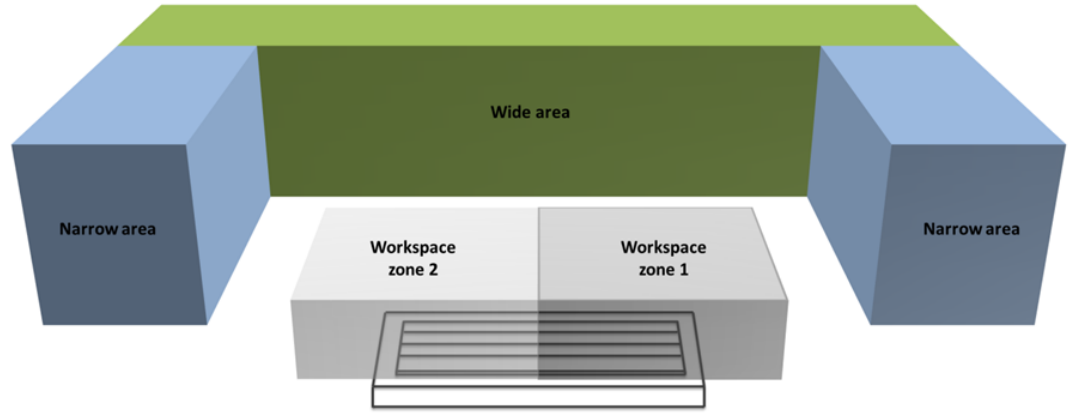
Figure 4. Admissible LT locations areas and workspace zones.